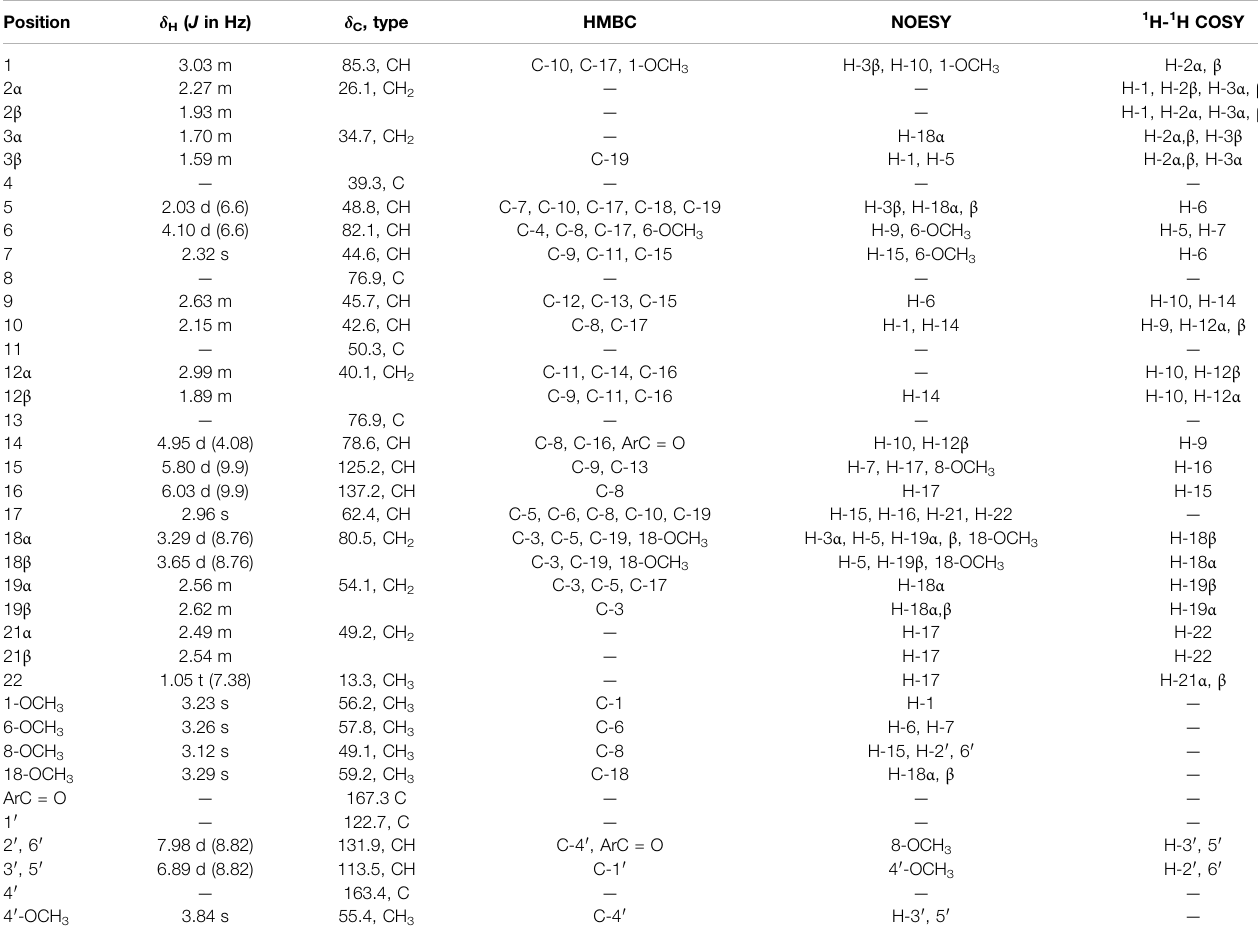
TABLE 2 | 1 H (600 MHz) and 13 C (150 MHz) NMR data for compound 2 (CDCl 3